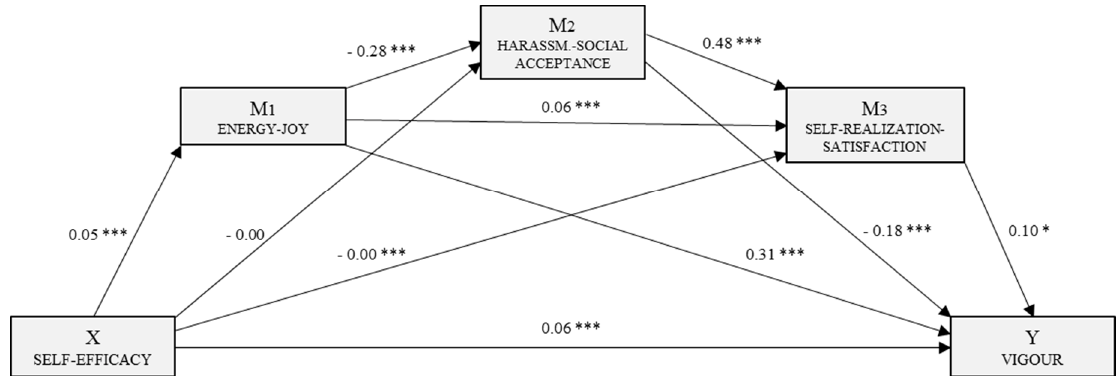
Figure 1. Multiple mediation model of perceived stress in the relationship between self-efficacy and the engagement dimension, Vigour. * p < 0.05; *** p < 0.001. J. Clin. Med. 2018 , 7 , x FOR PEER REVIEW